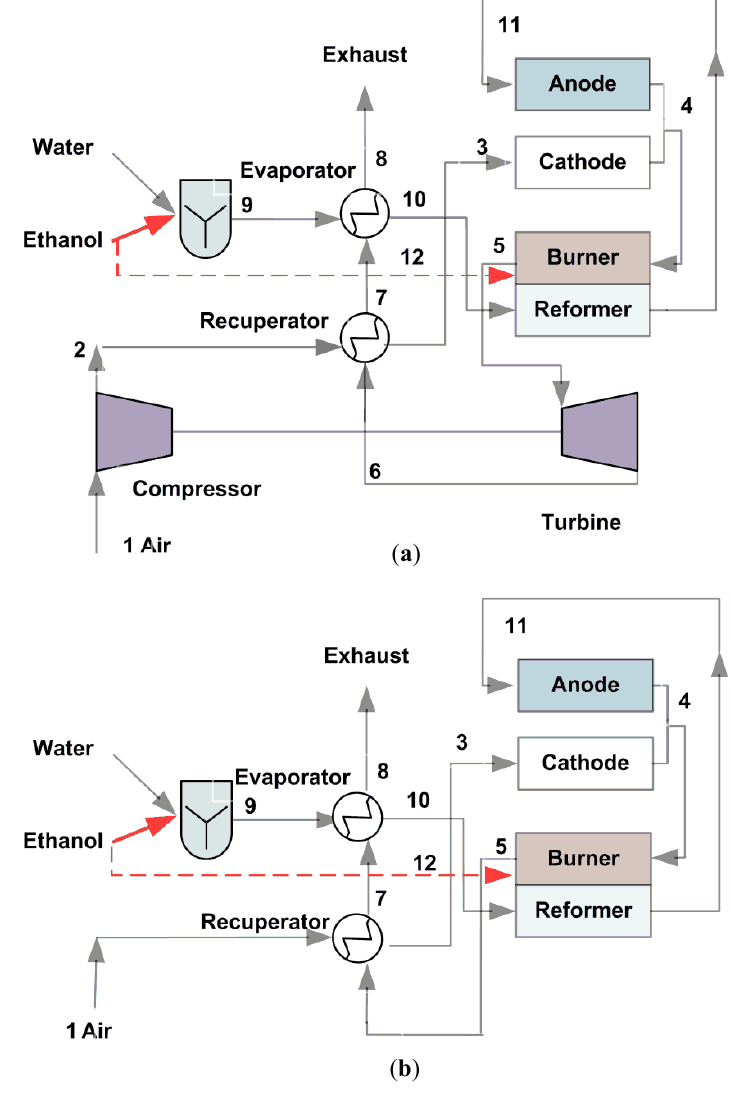
Figure 1. Systems’ configurations ( a ) SOFC-GT and ( b )